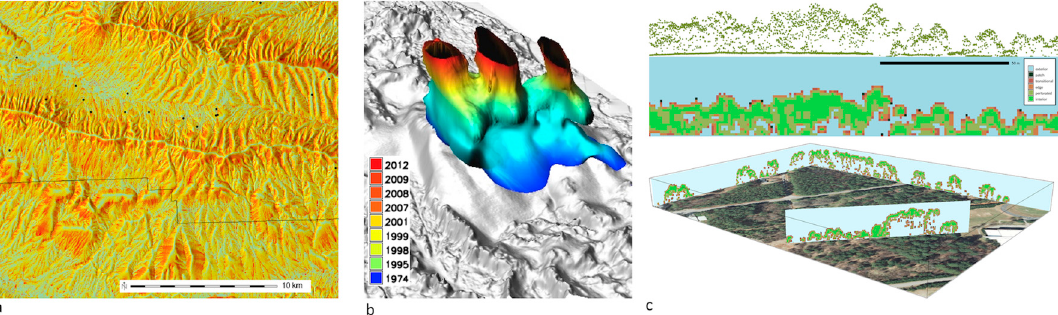
Figure 2. Spatial and multi-temporal data analysis and landscape process modeling with GRASS GIS: ( a ) Soil erosion potential modeling [13]; ( b ) evolution of Jockey’s Ridge sand dune at 16 m elevation, visualized as iso-surface in space-time cube [14]; ( c ) 3D vegetation fragmentation index derived from lidar point cloud [15].